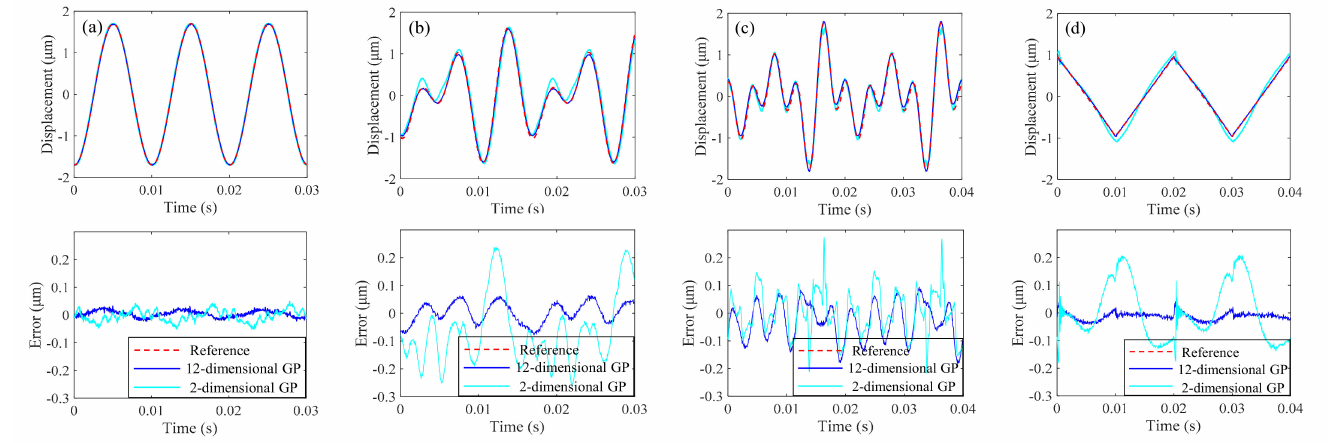
Figure 5. Tracking results of the open − loop controller under different reference signals: ( a ) 100 Hz sinusoidal signal; ( b ) dual − frequency mixed − signal; ( c ) four − frequency mixed − signal; ( d ) 50 Hz triangular wave.